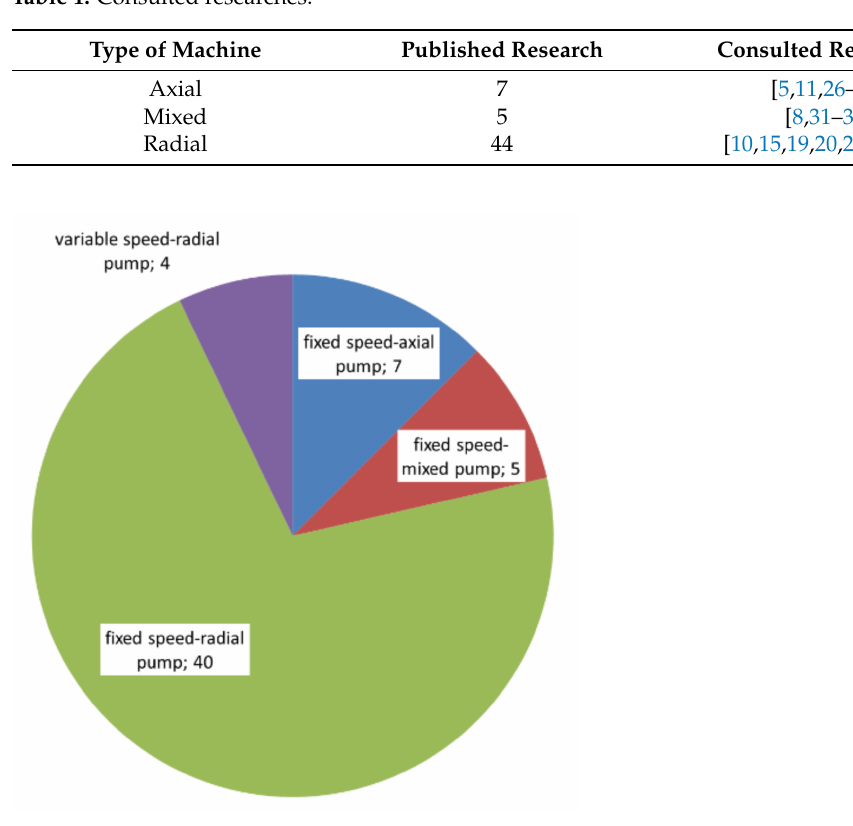
Figure 4. Consulted